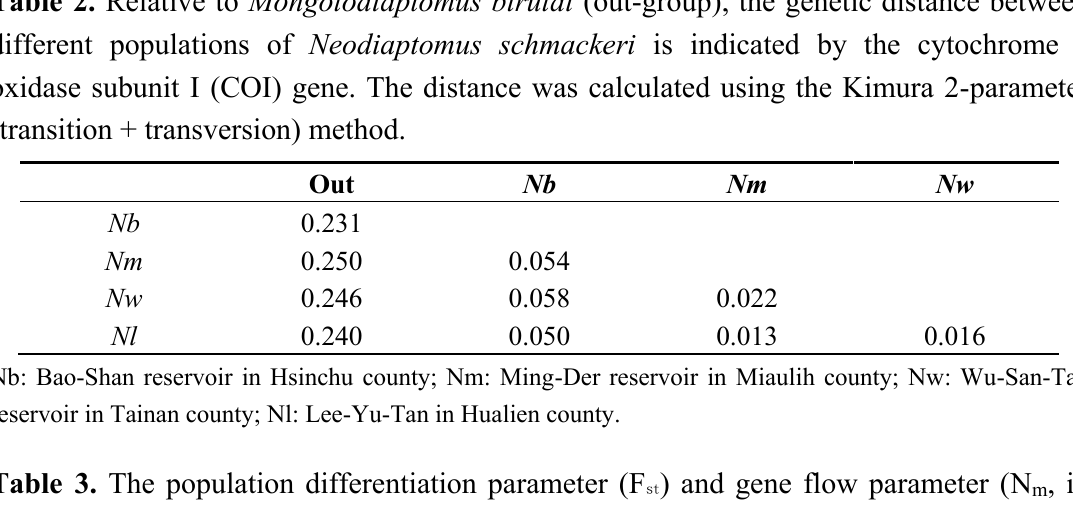
) and gene flow parameter (N , in m st